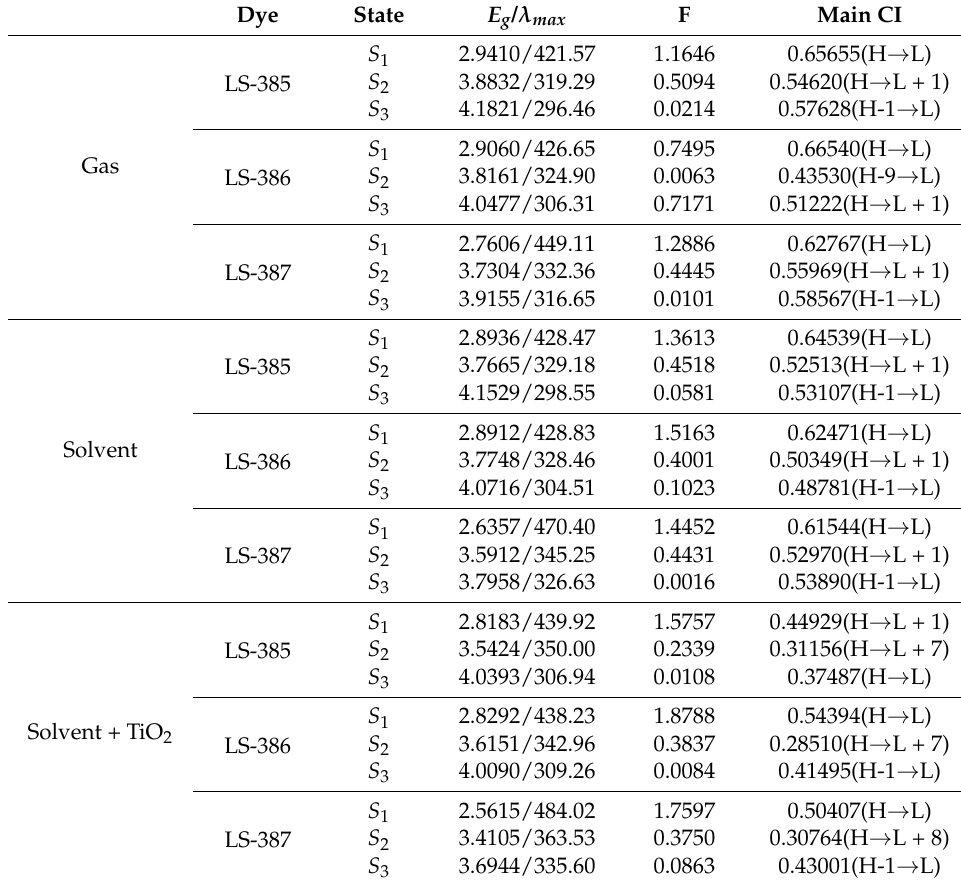
Table 2. The excitation energy and oscillator strength obtained by TD-DFT//Cam-B3LYP/6–31G(d) in vacuum and N,N-dimethylformamide (DMF)